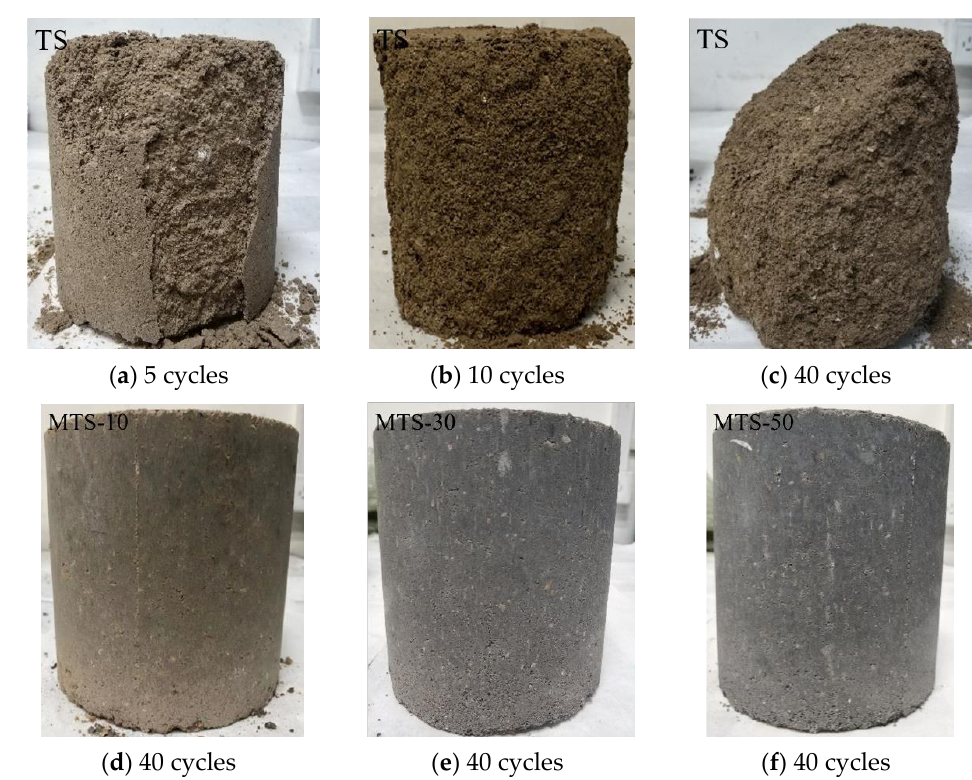
Figure 15. Damage to specimens at different freeze-thaw cycles.